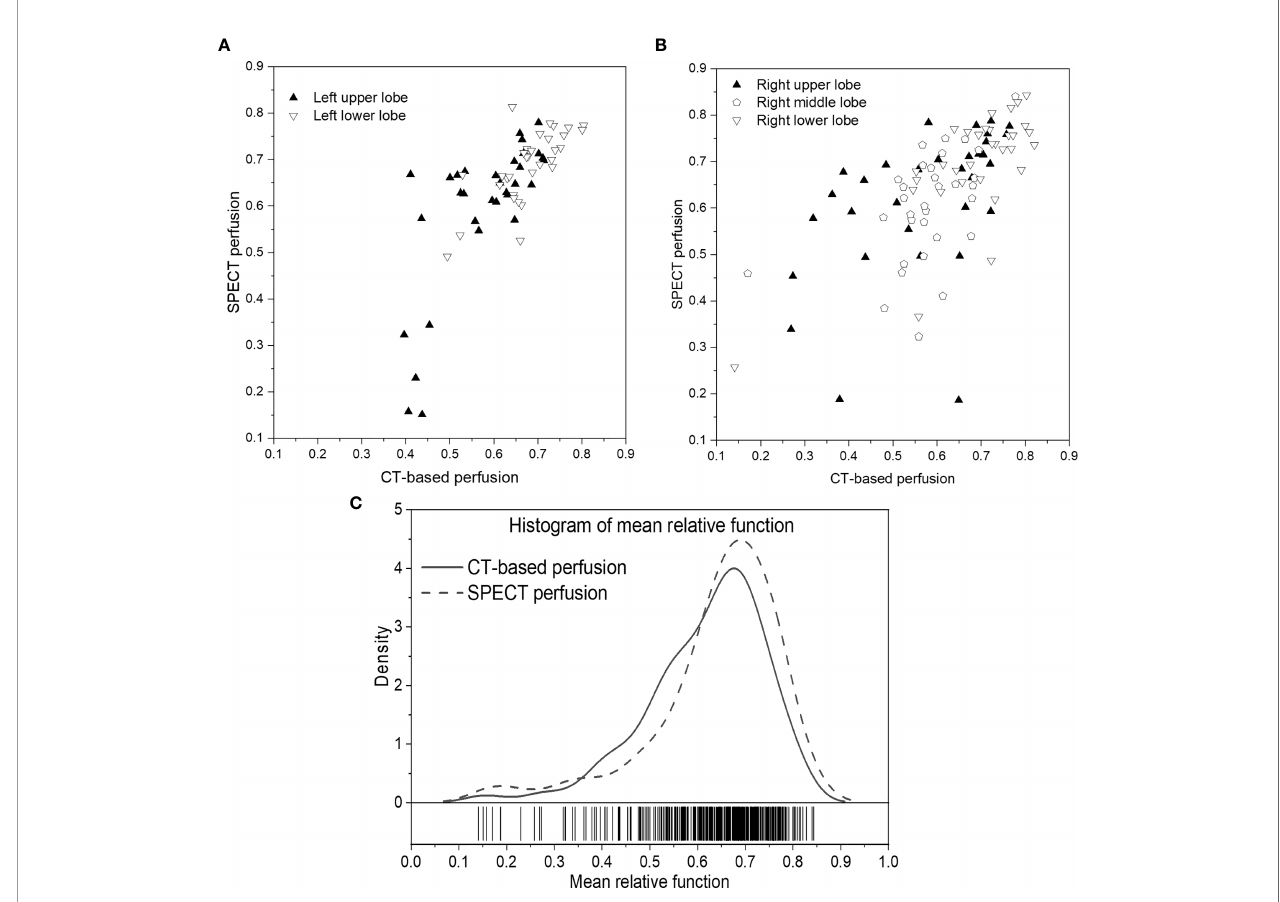
FIGURE 4 | Scatter plots of the mean relative perfusion value in each lobe between SPECT perfusion images and CT-based perfusion images of the left lung (A) and right lung (B) . (C) Histogram of the mean relative perfusion values of all the lobes. (A, B) show the scatter plots of the mean value of each lobe between SPECT perfusion images and CT-based perfusion images. The correlations of the mean perfusion value on LUL, LLL, RUL, RML, and RLL were 0.7314, 0.7134, 0.5108, 0.4765, and 0.7618, respectively. The regional accuracy of CT-based perfusion on the RUL and RML was lower than the performance on other lobes. For the histogram of mean perfusion function, the histogram of CT-based perfusion images was lower than SPECT perfusion images in the range of 0 to 0.35 and 0.6 to 1, while higher on the other